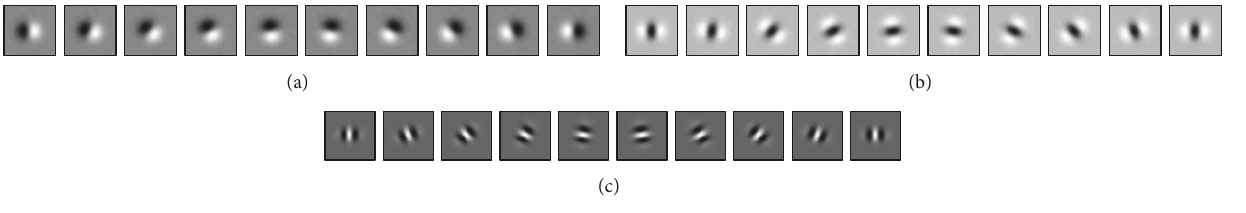
Figure 3: SIGDF with 𝜎 2 = 4 , 𝜃 = 𝑘𝜋/10 , and 𝑘 = 0,1,2, .. ., 9 . (a) 𝐺 𝜃 1,𝜎 , (b) 𝐺 𝜃 2,𝜎 , and (c) 𝐺 𝜃 4,𝜎